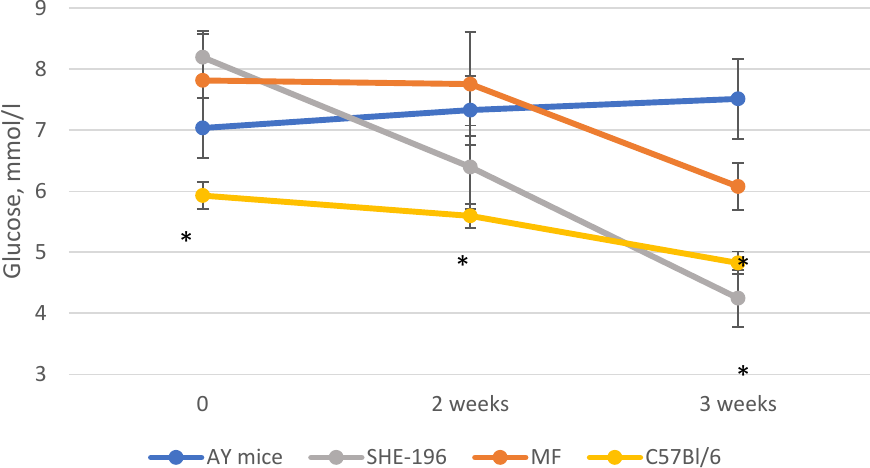
Figure 4. Body mass evaluation during 3-week treatment of AY mice by SHE-196 at a dose of 15 mg/kg. MF was introduced at a dose of 250 mg/kg. * p < 0.05 compared to AY mice.